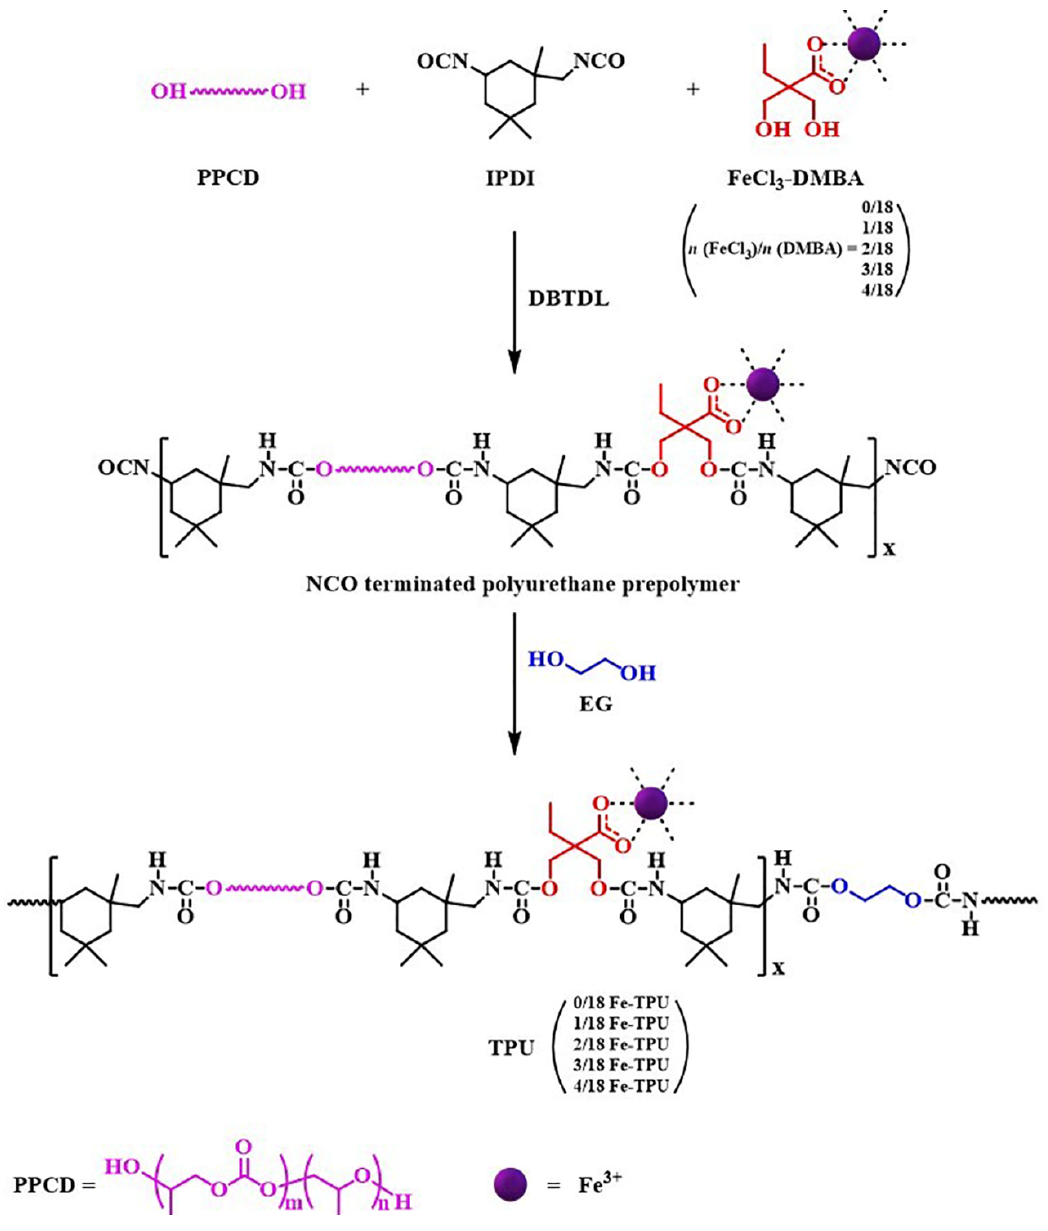
Scheme 1. Synthesis diagram of TPU.